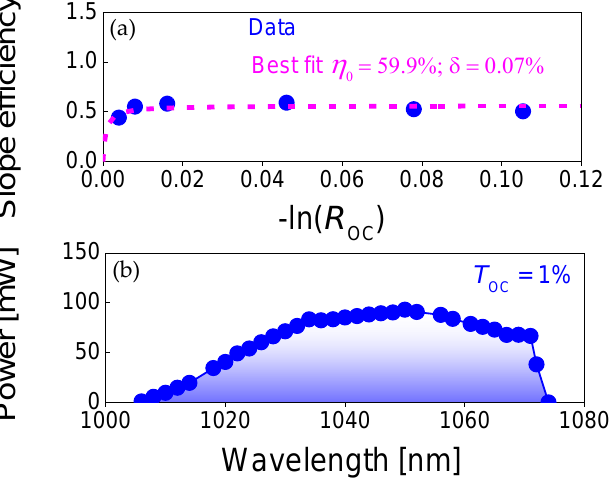
Figure 3. Caird analysis for the CW Yb:GdCB laser: ( a ) slope efficiency as a function of the OC reflectivity R OC = 1 − T OC ; ( b ) wavelength tuning curve obtained with an SF-10 Brewster prism placed between M 1 and the OC with T OC = 1%.